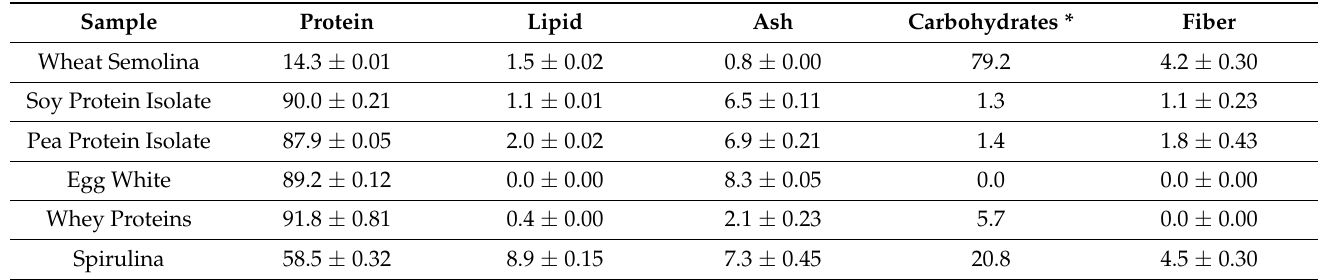
Table 4. Proximate composition (g/100 g d.w.) of wheat semolina and other raw materials.